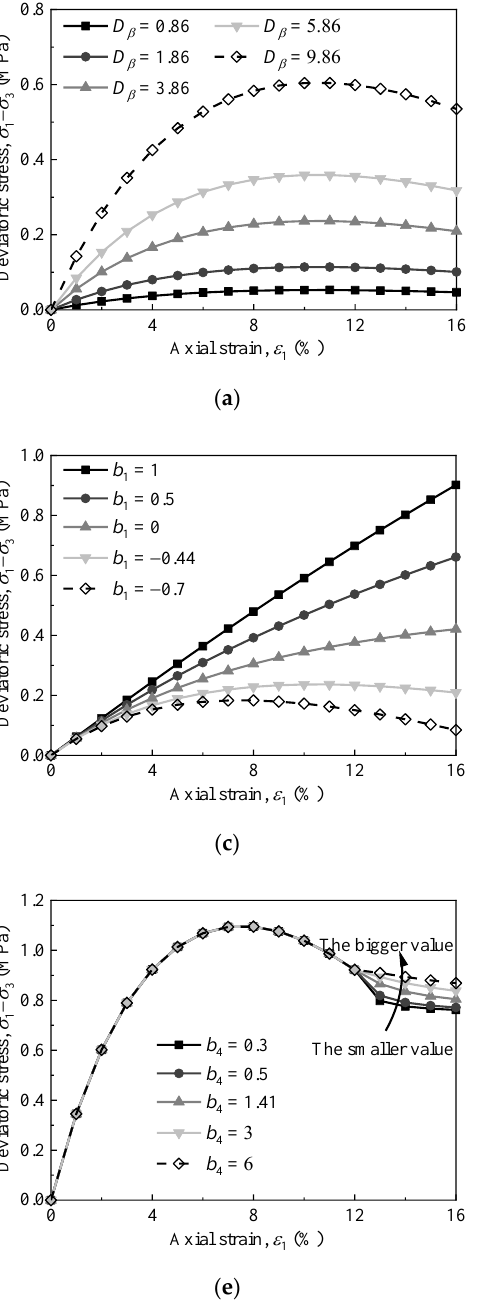
Figure 10. Deviatoric stress – strain curves of the proposed model for different values of parameters: